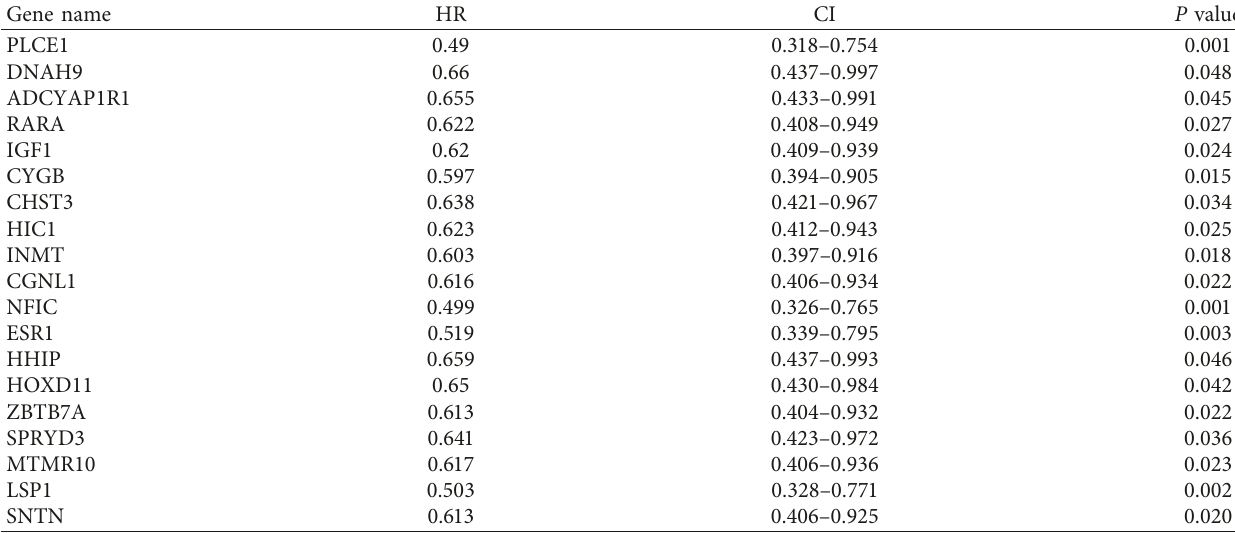
Table 4: The relationship between miR-149-3p target gene expression level and